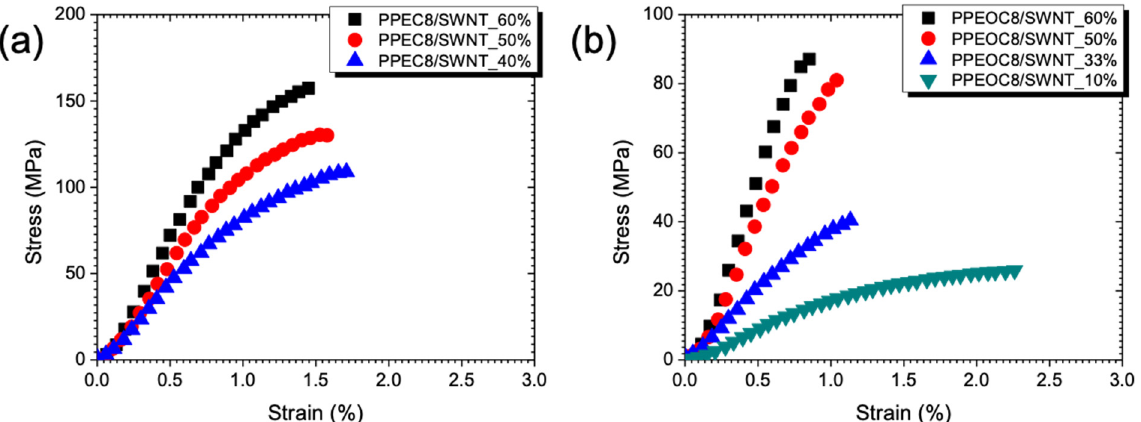
Figure 7. Stress–strain curves of the PPE/SWNT nanocomposites with various SWNT loadings. ( a ) PPEC8/SWNT and ( b ) PPEOC8/SWNT. The SWNT loading is shown in the plots.